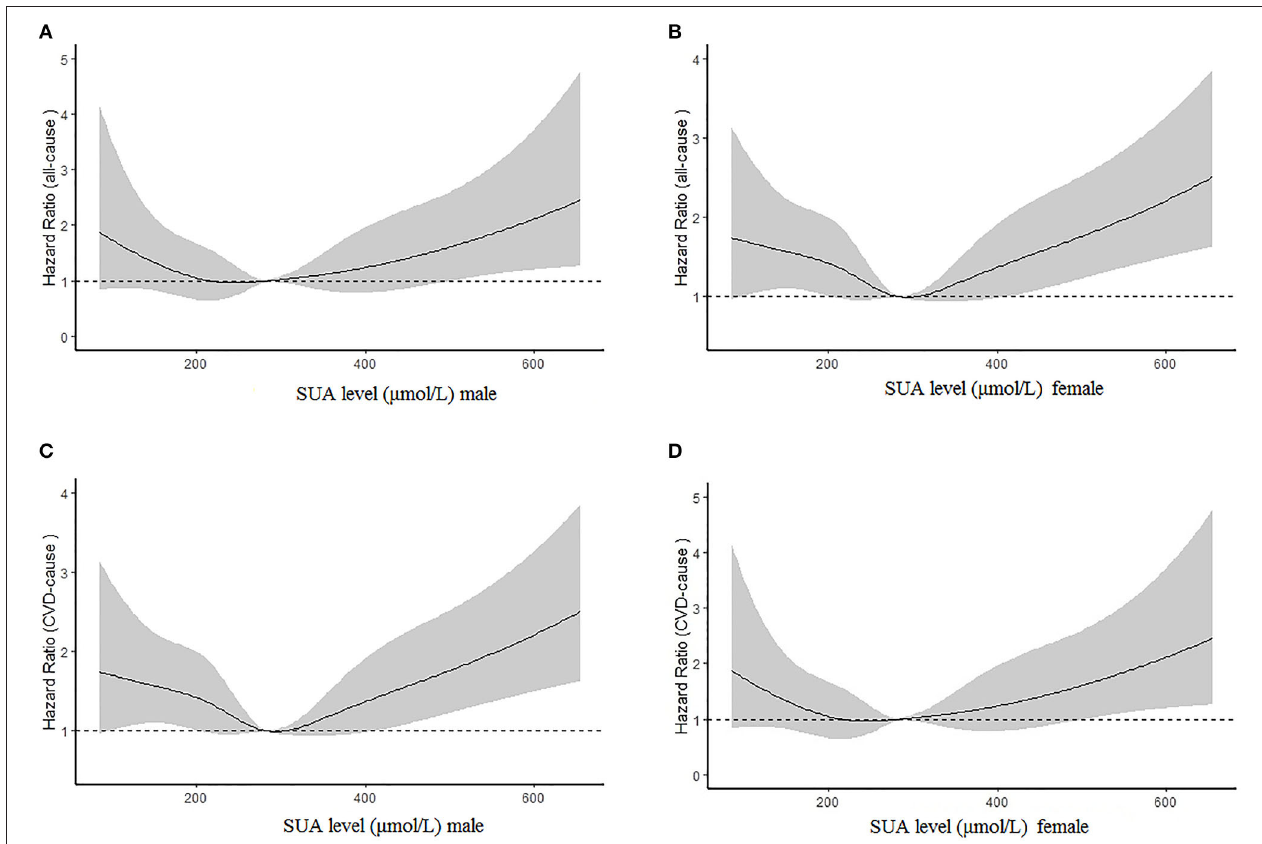
FIGURE 3 | Multivariable adjusted cubic spline models for the association between serum uric acid (SUA) level and hazard ratios (HRs) for all-cause mortality among males (A) and females (B) and cardiovascular disease (CVD) mortality between males (C) and females (D)